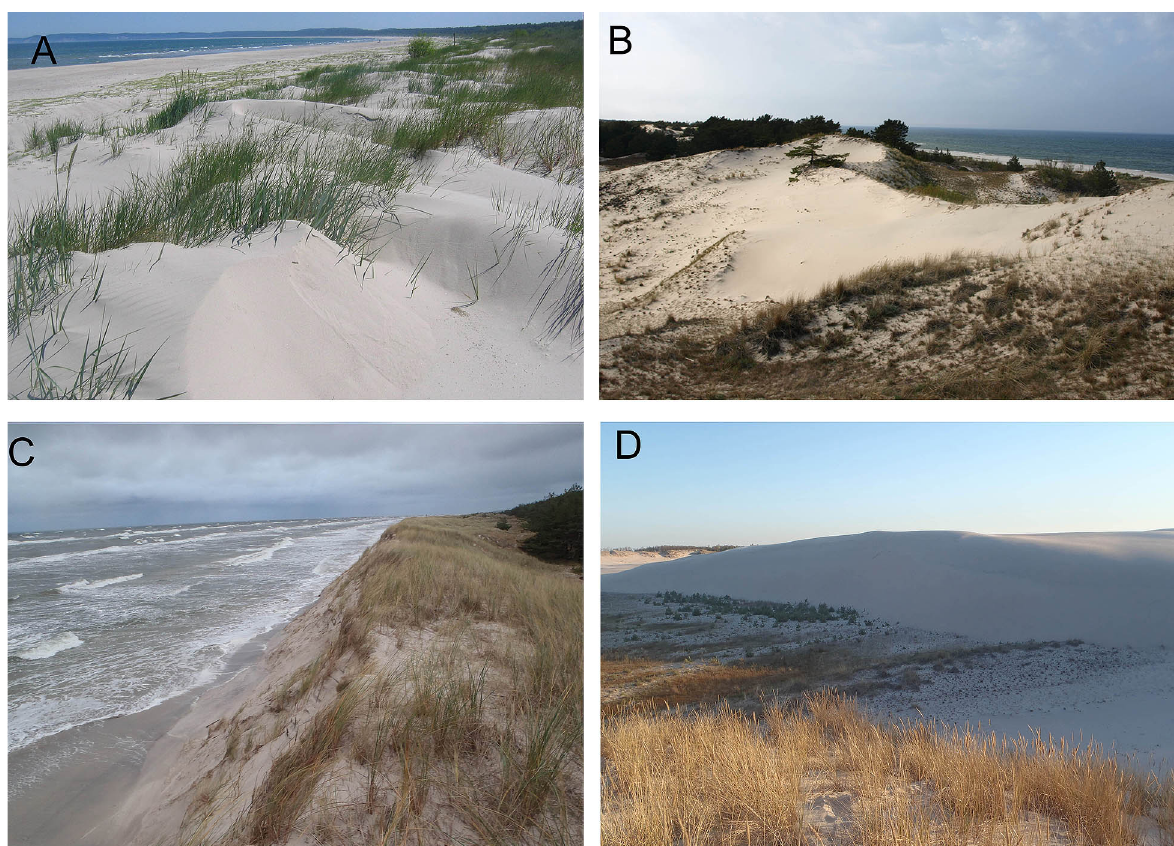
Fig. 5. Examples of well developed sandy-dune coast in Poland, South Baltic Sea (Photo T. Łabuz ). A – embryo and foredune on prograding coast of Świna Gate Sandbar, B – blown off transverse dunes of Hel Spit promontory, south from Jurata, C – erosion of huge foredunes developed through last 30 years, Stilo, kashubian Sandbar, D – wandering dunes of Łebsko Lake Sandbar – barchan type dune is entering low-lying